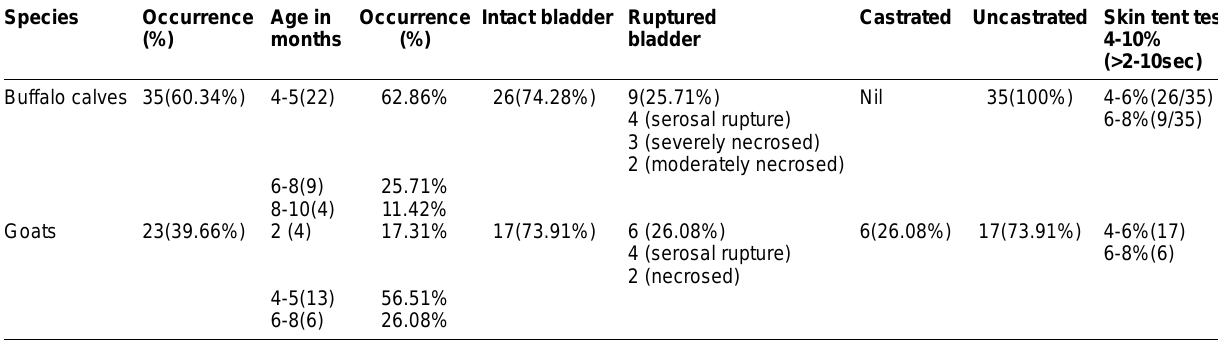
Table-1: Distribution of cases and different occurrence of urolithiasis in ruminants